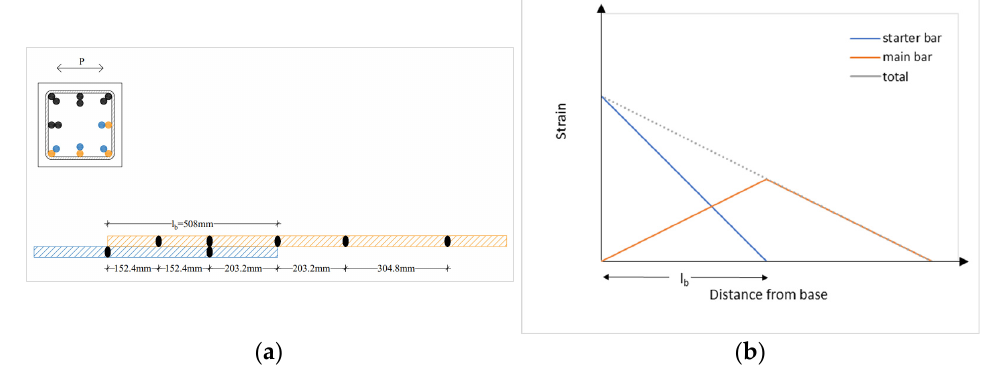
Figure 8. ( a ) Strain gauges layout. ( b ) Expected strain distribution along lap-spliced bars (based on [107]).